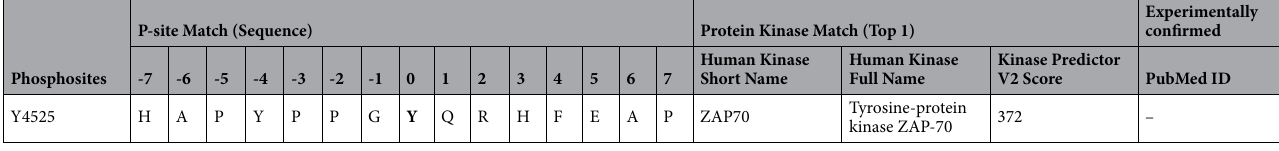
Table 2. FAT1 protein phosphorylation.